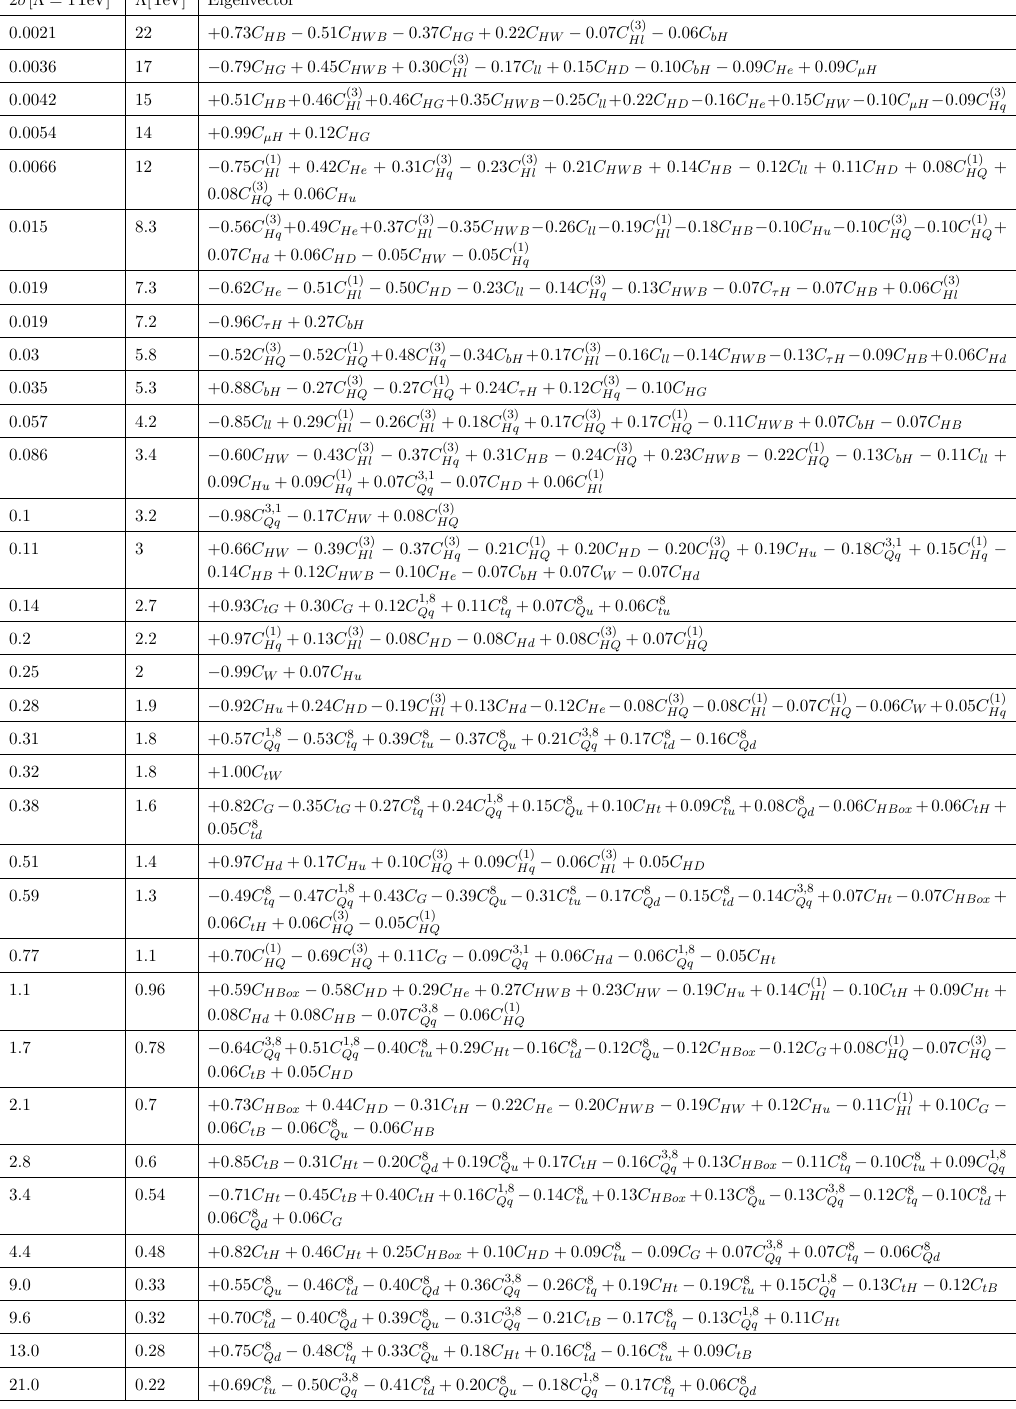
Table 8 . Components of the eigenvectors found in the principal component analysis of the global fit displayed in figure 13. Components with coefficients of magnitude less than 0.05 are